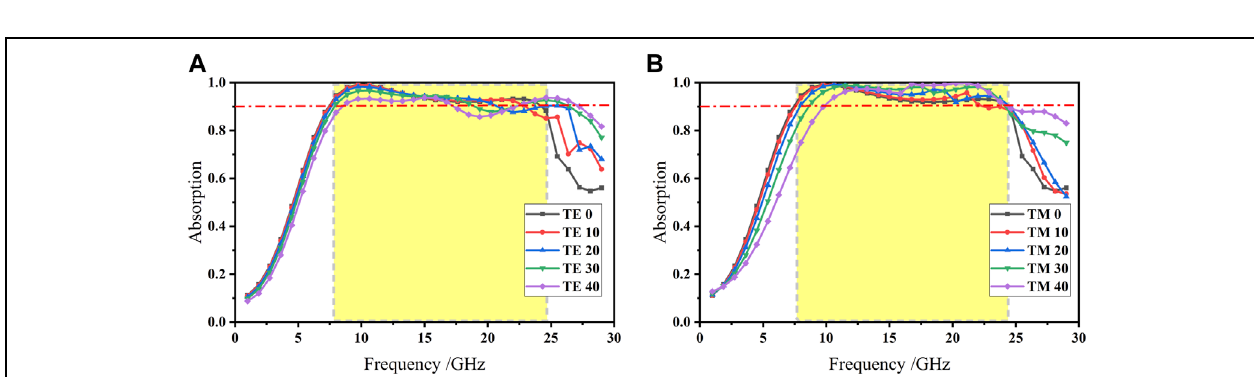
FIGURE 6 | Schematic diagram of partial results under the 8 ∼ 20 GHz customized design. (A) The designed results of W 1 . (B) The designed results of L 1 . (C) The designed results of W